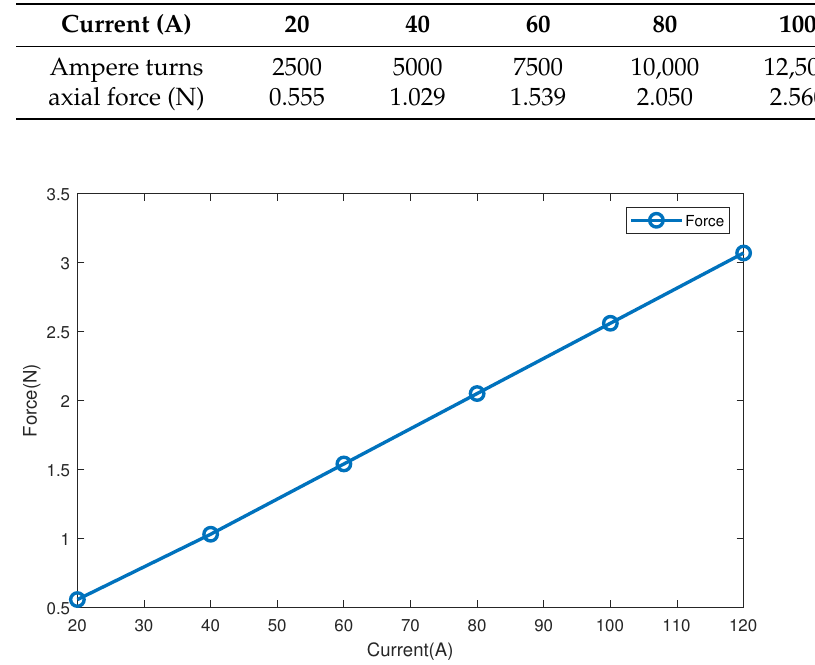
Figure 10. Relation curve of electromagnetic force and current.axial coil distance 264